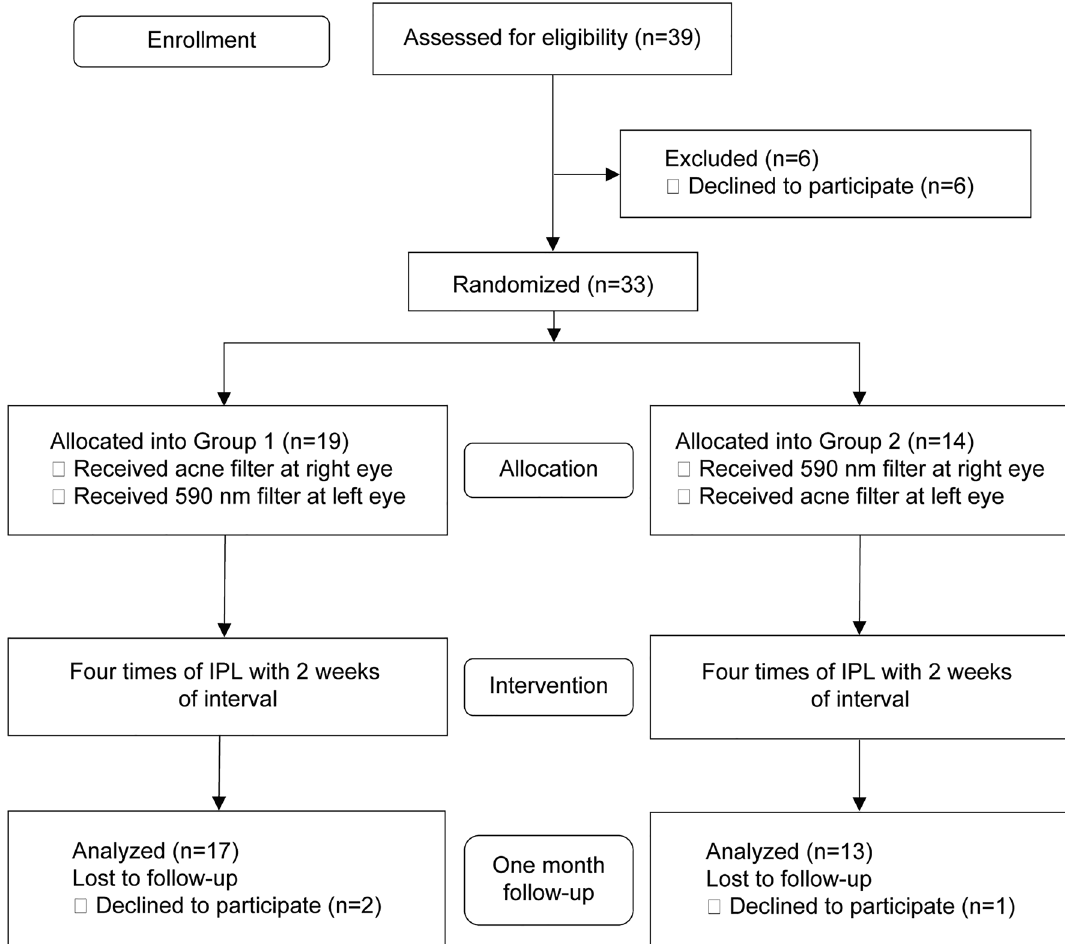
Figure 1. Flow diagram according to the consolidated standards of reporting trials (CONSORT) statement, showing enrollment, randomization, and patient flow in this study for moderate and severe meibomian gland